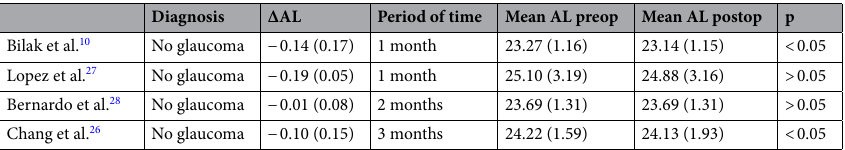
Table 6. AL difference before and after phacoemulsification and IOL implantation. All of the patients, described in the literature, did not have